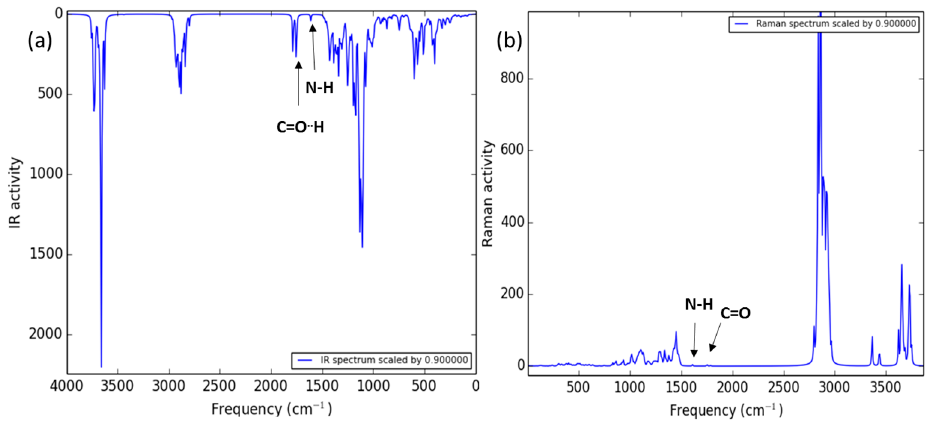
Figure 7. HF/STO-3G calculated IR ( a ) and Raman ( b ) spectra of PCL/ β -CD-NH 2 IC.